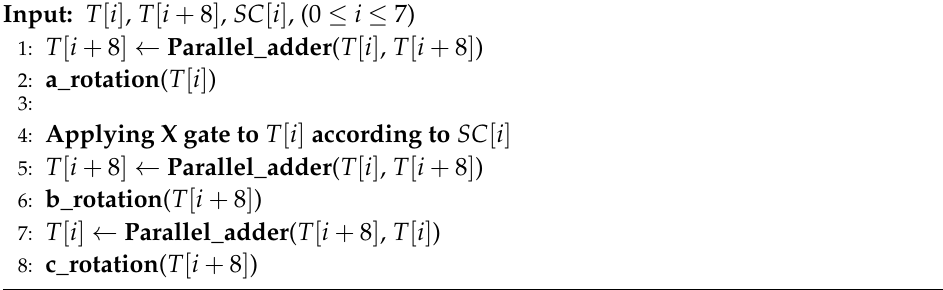
Algorithm 2 Quantum circuit of the Mix